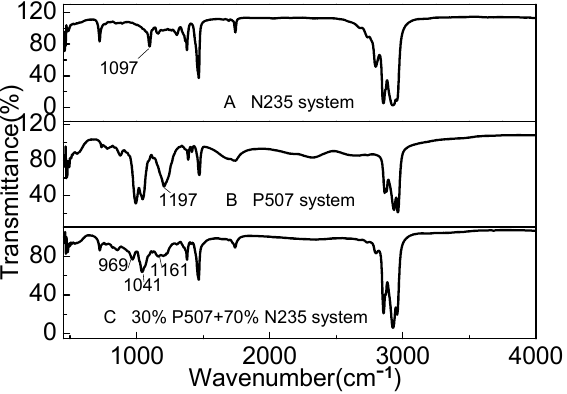
Figure 12. IR spectra of ( A ) N235, ( B ) P507, and ( C ) P507–N235 system (V extractant : V kerosene = 1:3). The IR spectra before and after Co extraction by the P507–N235 system are shown in Figure 13. The peaks fluctuated between 3250 and 3750 cm −1 , which indicates the presence of an aqueous phase. After extraction, the P=O bond moved to low frequency, the peak increased slightly, and the peak became sharp. It is possible that the coordination between Co and extractants altered the symmetry and led to the change in the dipole moment of the P=O bond. The characteristic peak of the tertiary amine group of N235 was weakened after extraction, indicating that the tertiary amine group participated in the reaction.